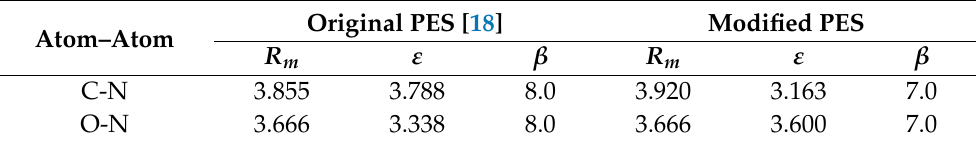
Table 2. Parameters for the CO-N 2 intermolecular potentials. R m (Å) and ε (meV) values define the vdW components in the corresponding atom–atom